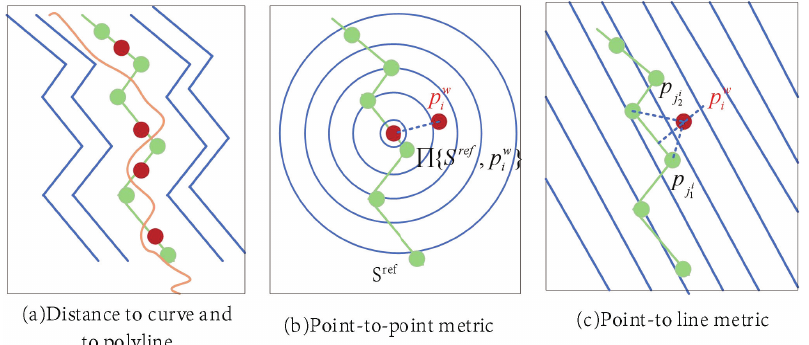
Figure 14. In this figure, the green point is the LIDAR point at time t − 1, the yellow line is the real object (such as a corridor or wall), and the red point is the point at time t. ( a ) The figure represents the trajectory of the real object; ( b ) the dotted line between two red dots in the figure represents the error distance between the real point and the predicted point of the ICP algorithm; ( c ) the dotted line between two red dots in the figure represents the error distance between the real point and the predicted point of the PL-ICP algorithm. It can be concluded that the error distance of the PL-ICP algorithm is shorter than that of the ICP algorithm in the same